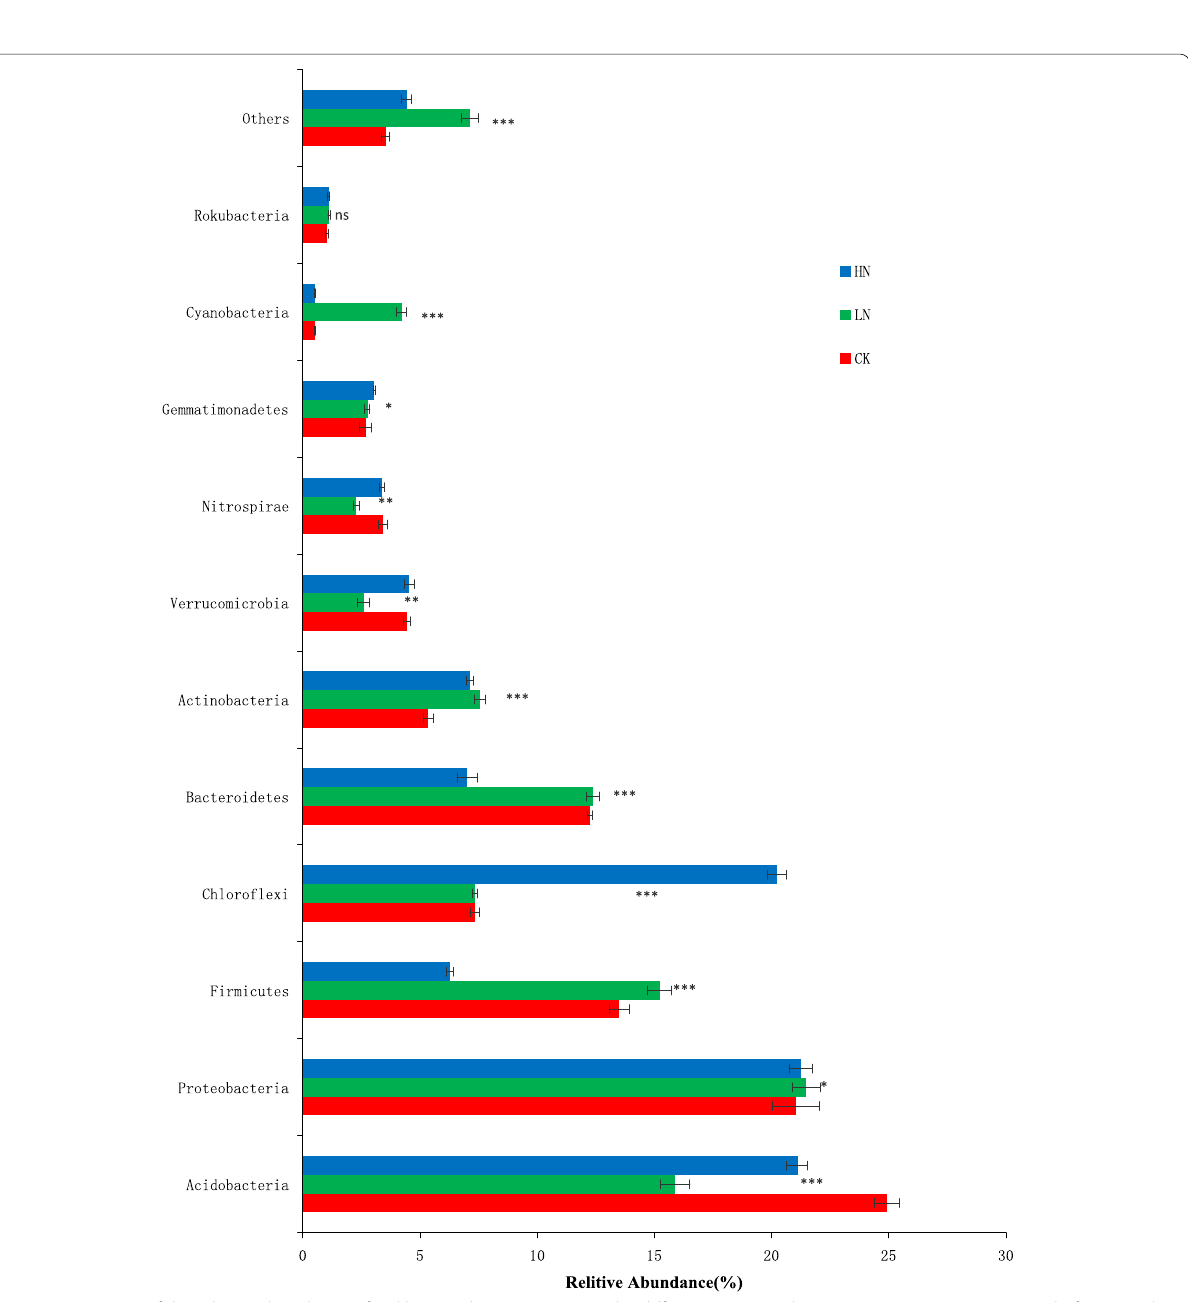
Fig. 2 Histogram of the relative abundance of soil bacterial communities under different nitrogen deposition treatments. Note: Level of statistical significance determined by one‑way ANOVA (*** P < 0.001, ** P < 0.01, * P < 0.05) within a particular phylum between the different nitrogen deposition